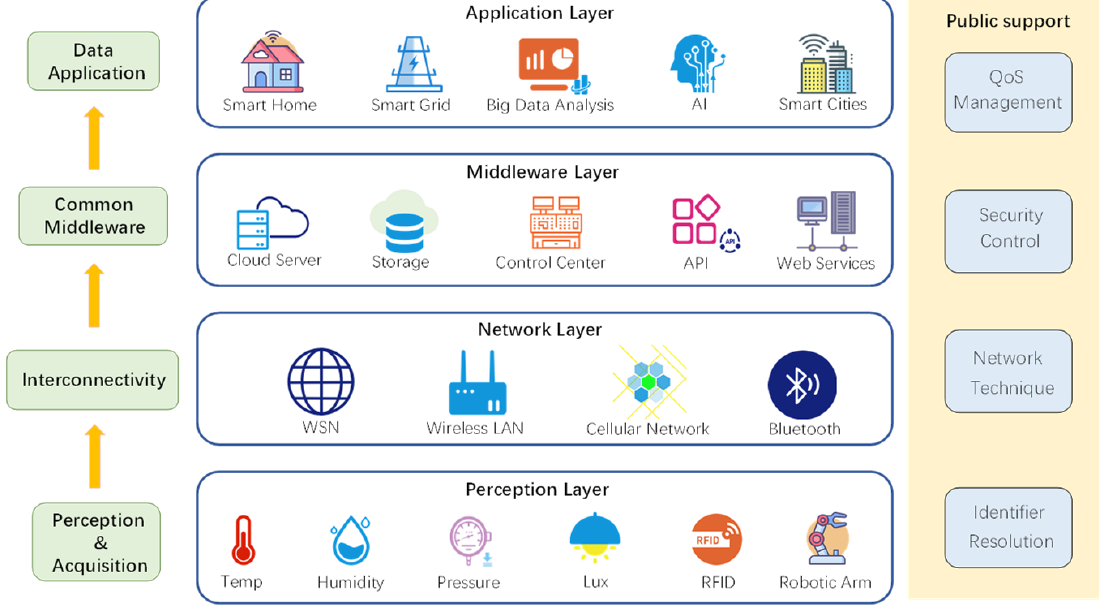
Figure 2. The four-layer architecture of IIoT.